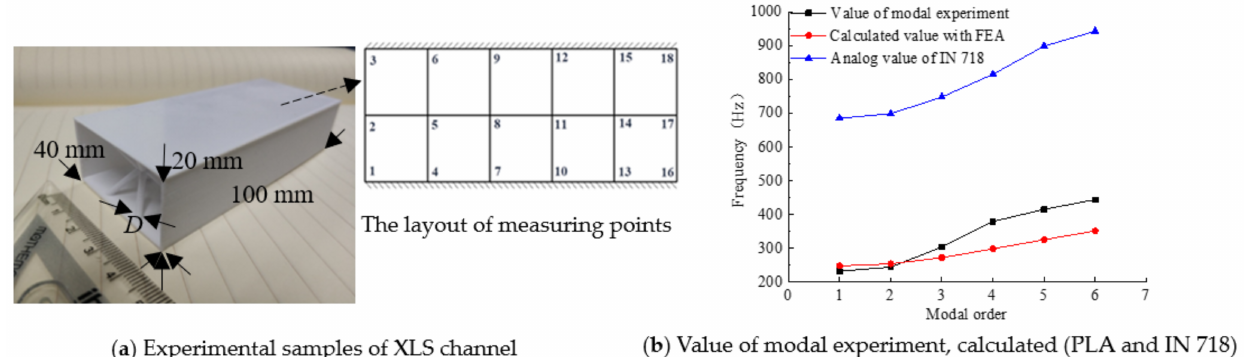
Figure 3. Printed XLS cooling channel and validation of freq